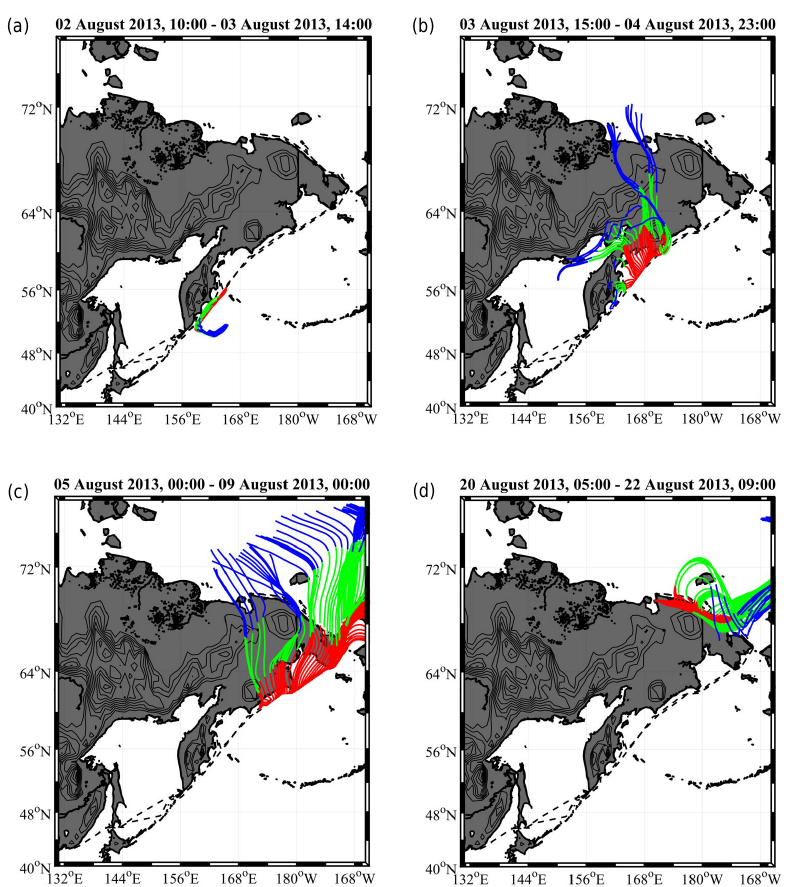
Figure 4. Trajectories of air mass motion: red is for the third day of motion of air masses, green is for the second day, and blue is for the first